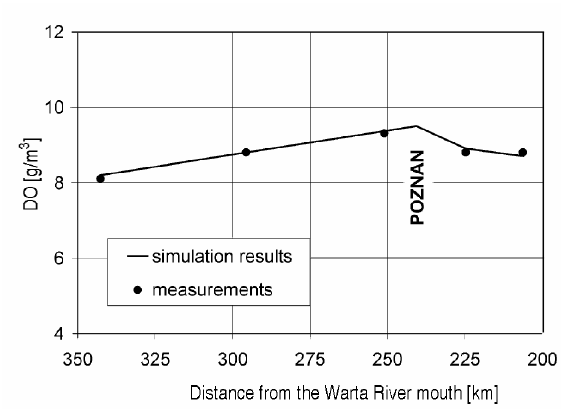
Fig 3. Comparison of measured and simulated DO con- centrations in analysed reach of the Warta River for 2 July